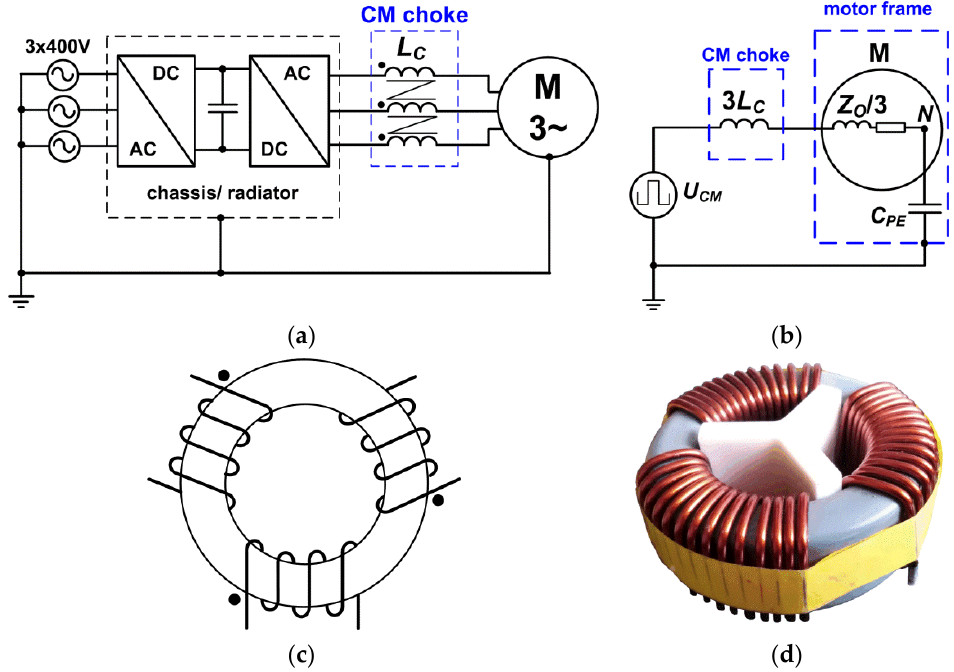
Figure 12. Electric drive with a CM choke: ( a ) application scheme, ( b ) equivalent circuit for common-mode components, ( c ) CM choke realization, ( d ) view of commercial CM choke type BE1871/720μH (TTI) .